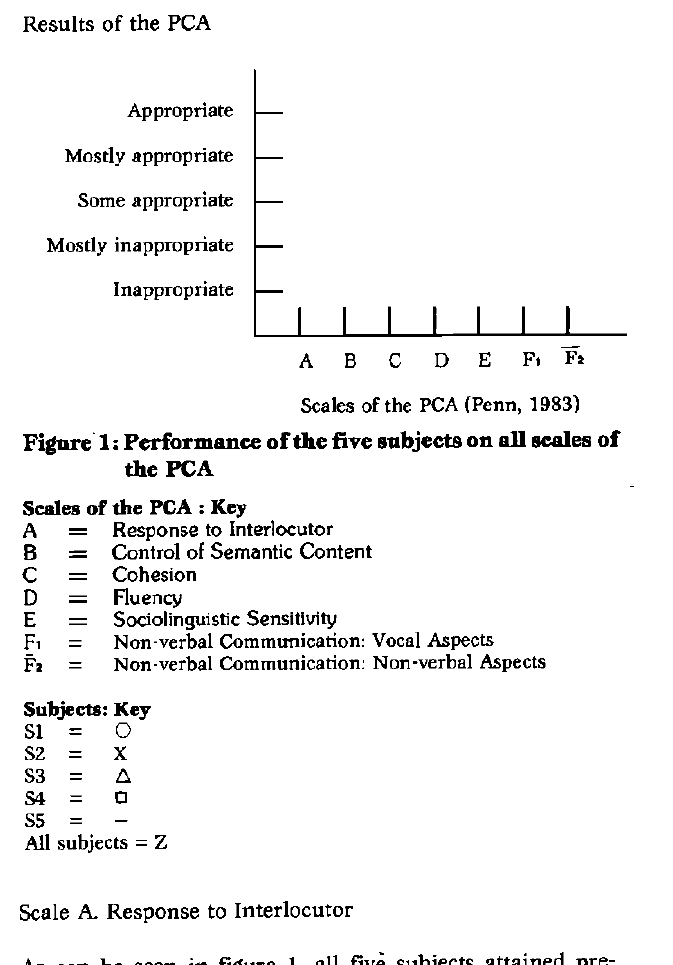
Figure 1: Performance of the five subjects on all scales of the